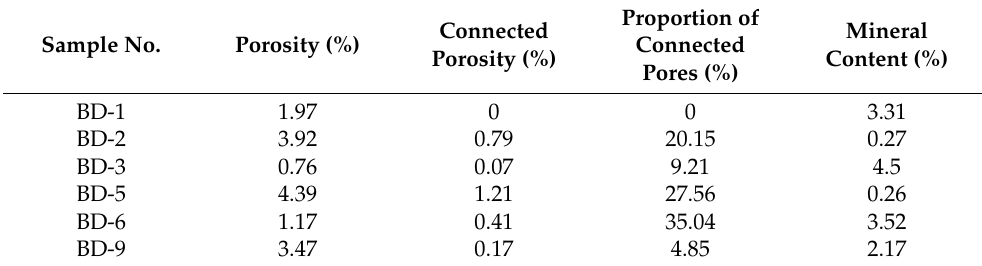
Table 7. X-ray CT imaging test results of typical samples.